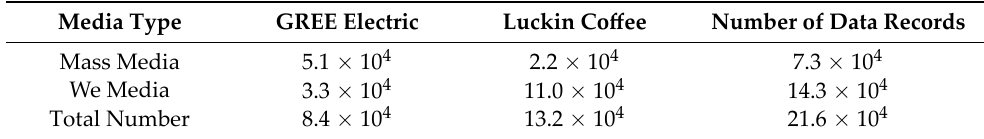
Table 5. Data summary displayed in the experimental